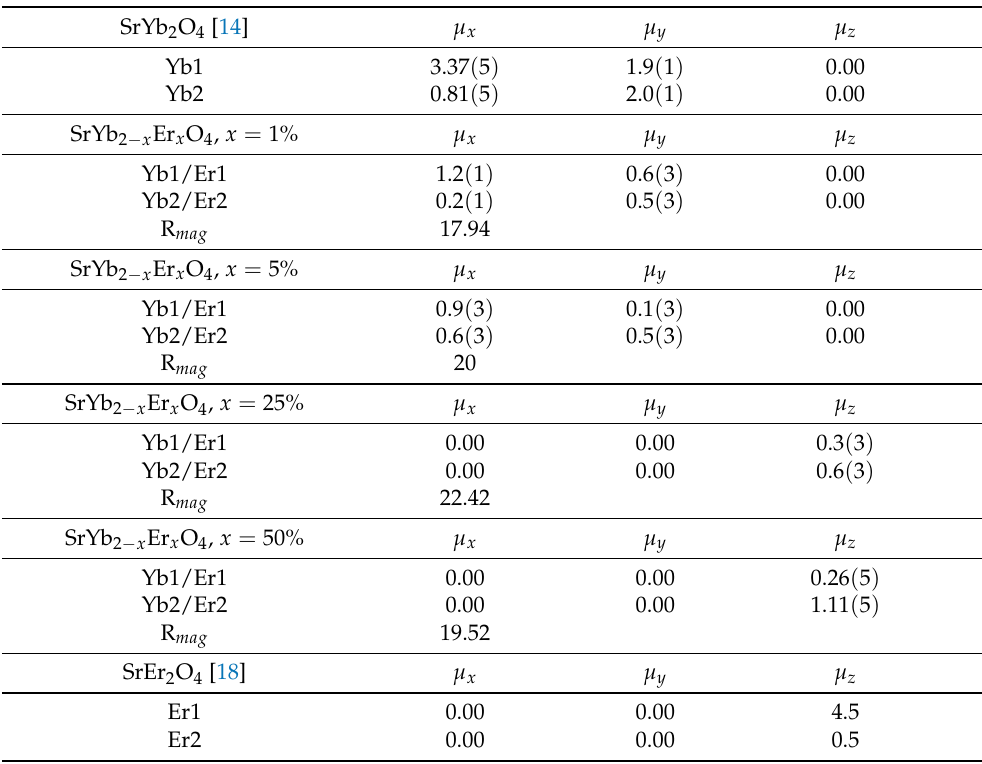
Table 2. Moments along the different crystallographic directions for 1, 5, 25, and 50% samples. Obtained from the refinement of DMC